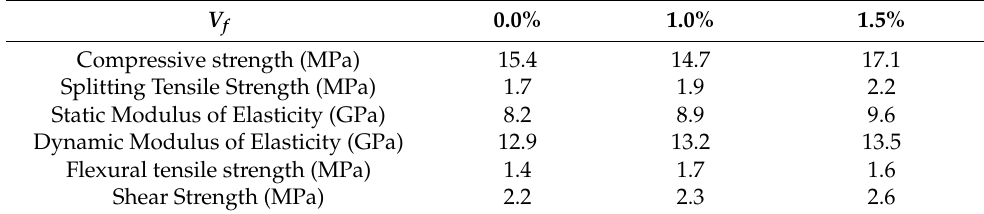
Table 2. Mechanical characteristics.